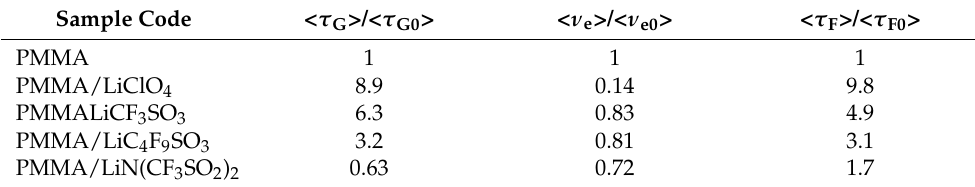
Table 2. The specific ratio of the mean relaxation times in glassy and flow regions and the specific entanglement densities of the dried salt-doped samples. The suffix 0 indicates the pristine-PMMA. Sample Code < τ G >/< τ G0